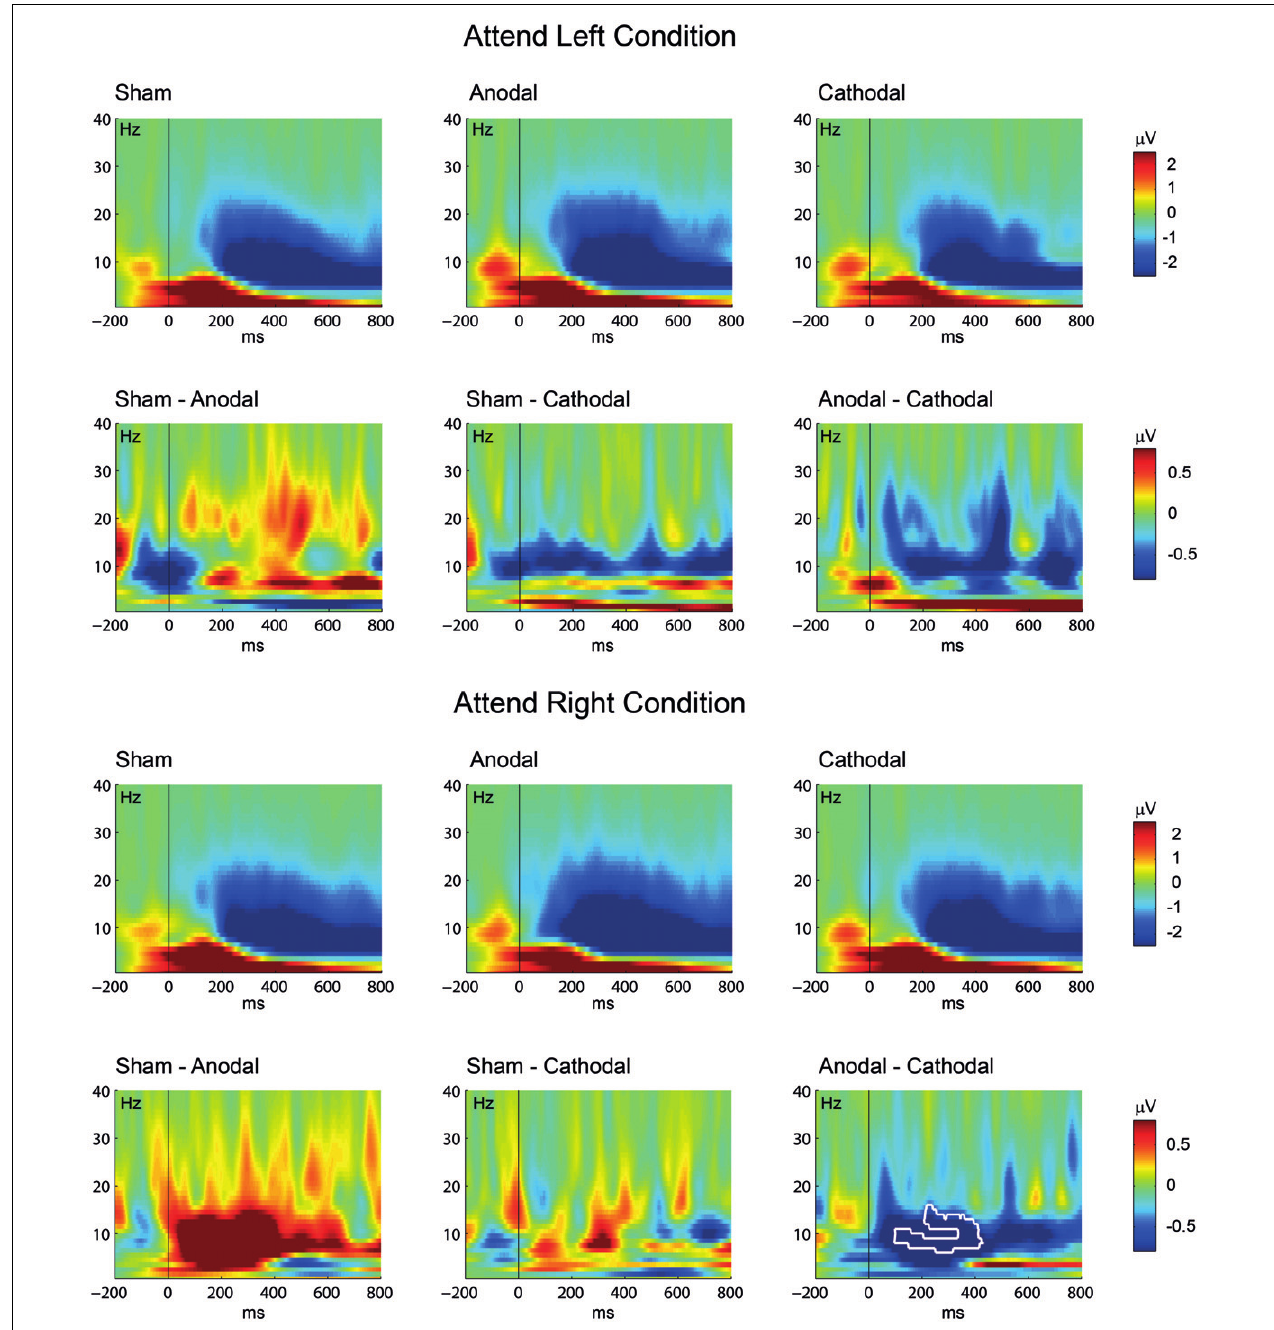
cathodal) from the sham ERSP (left and middle row) or by subtracting the cathodal ERSP from the anodal ERSP (right row).The white contour indicates significant differences between the conditions ( P < 0.05, corrected for multiple comparisons). Note the different scaling for the ERSP plots (sham, anodal, and cathodal condition; upper rows) and the difference plots (lower